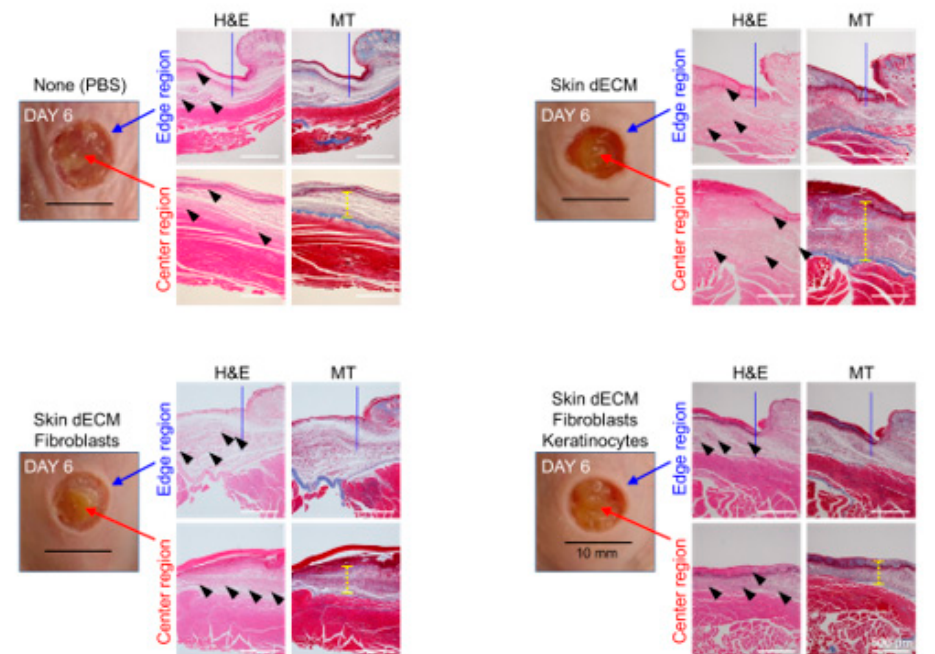
Figure 5. Histological analysis of cell infiltration and collagen deposition. Tissue samples stained with hematoxylin and eosin, and Masson’s trichrome stain, were analyzed at various stages on day 6. The images show stained tissue samples depicting the infiltration of cells into the dermal layer (black arrow heads) and fibrosis and collagen deposition at the site of damage (yellow line).